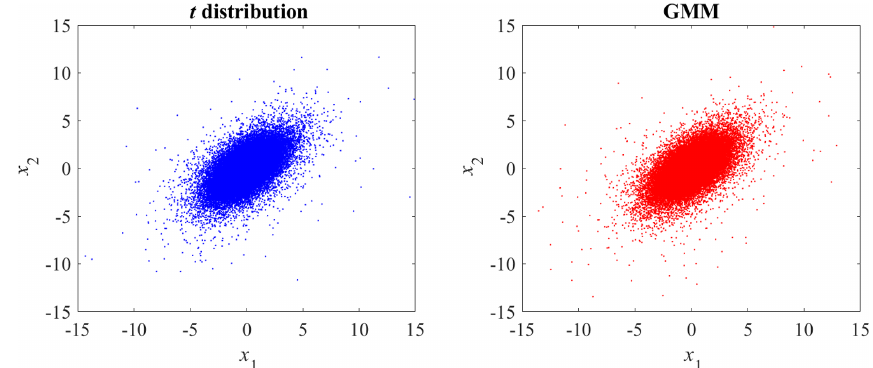
Figure 2. Random sample from the t distribution and GMM.